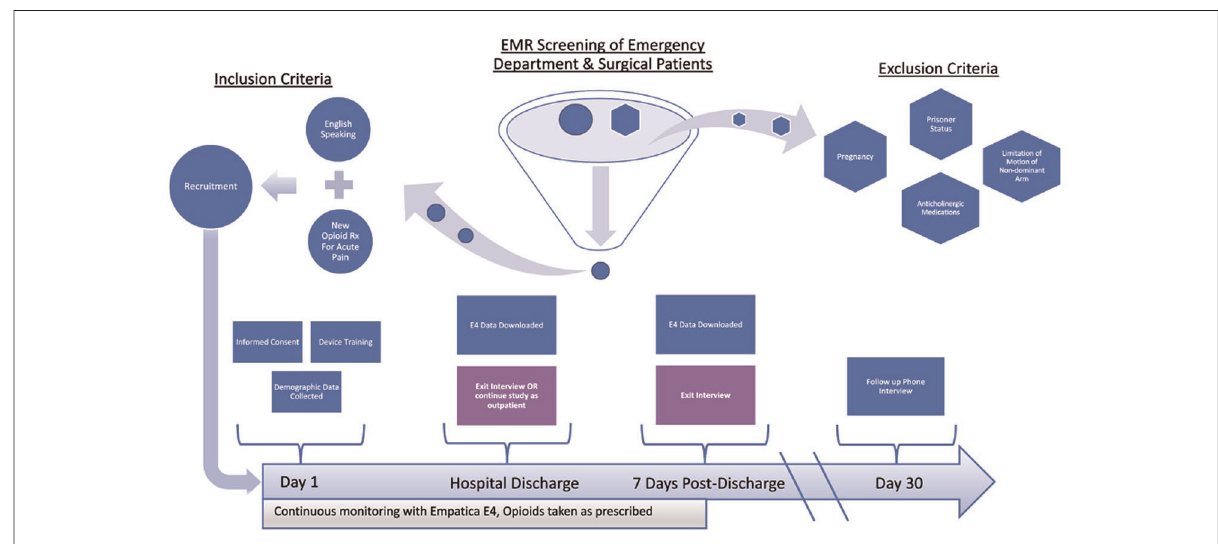
FIGURE 1 Screening process and study fl ow. EMR, electronic medical record; Rx,